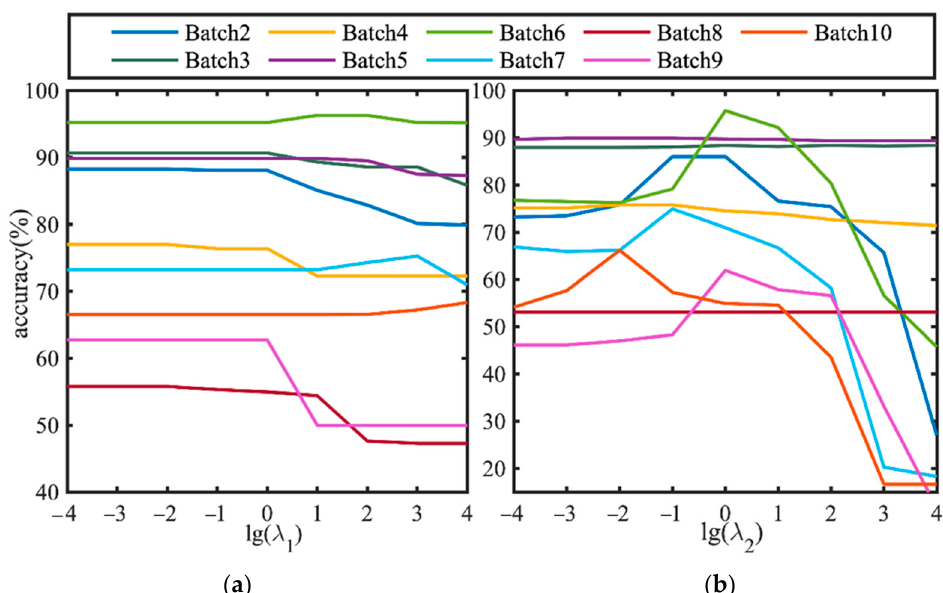
Figure 6. The impact of the trade-off parameters 𝜆 (cid:2869) and 𝜆 (cid:2870) on the algorithm recognition effect. ( a ) The influence of 𝜆 (cid:2869) on the algorithm; ( b ) the influence of 𝜆 (cid:2870) on the algorithm.